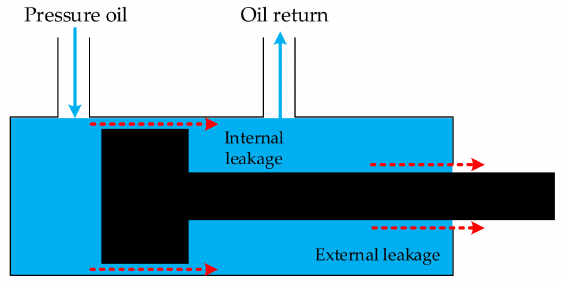
Figure 17. Basic principle of actuator